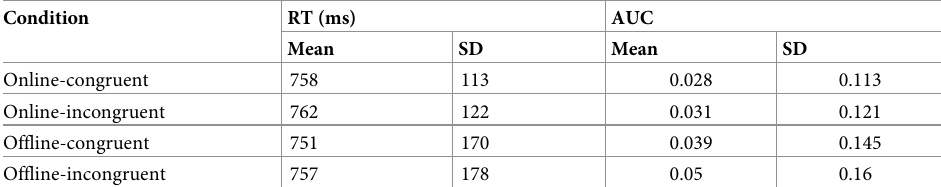
Table 1. Descriptive statistics in Experiment 3.